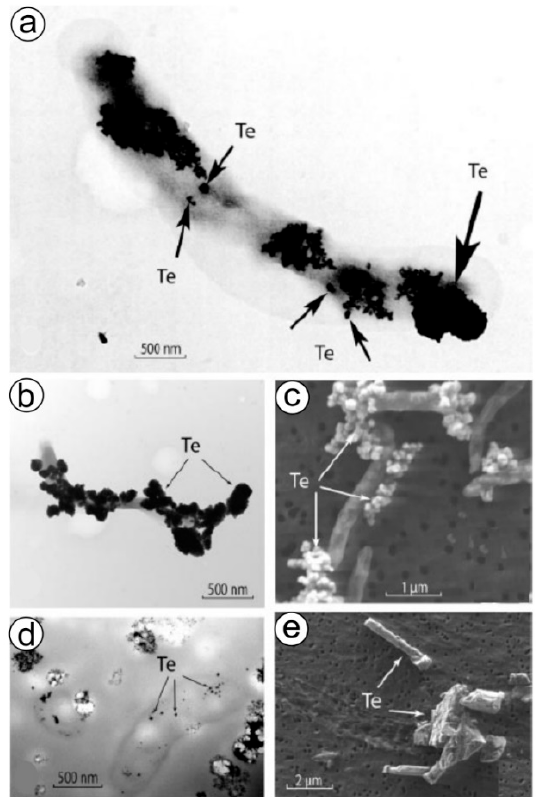
Figure 5. Formation of irregular Te(0) “nanospheres” by Sulfurospirillum barnesii. ( a ) Whole-mount TEM image of a single cell grown on Te(VI), showing abundant external Te nanospheres (small arrows) forming larger aggregates (large arrow) on the cell surfaces. ( b ) Lower-magnification TEM image of another single cell grown on Te(VI) showing abundant external Te nanospheres. ( c ) Wide-field SEM image of the Te(0) nanosphere aggregates formed after growth on Te(VI). ( d ) Unstained TEM thin-section image of cells grown on Te(VI) showing internal accumulations of Te(0). ( e ) SEM image of Te(0) obtained from a chemical supply house. Reproduced from [211] with permission from the American Society for Microbiology.